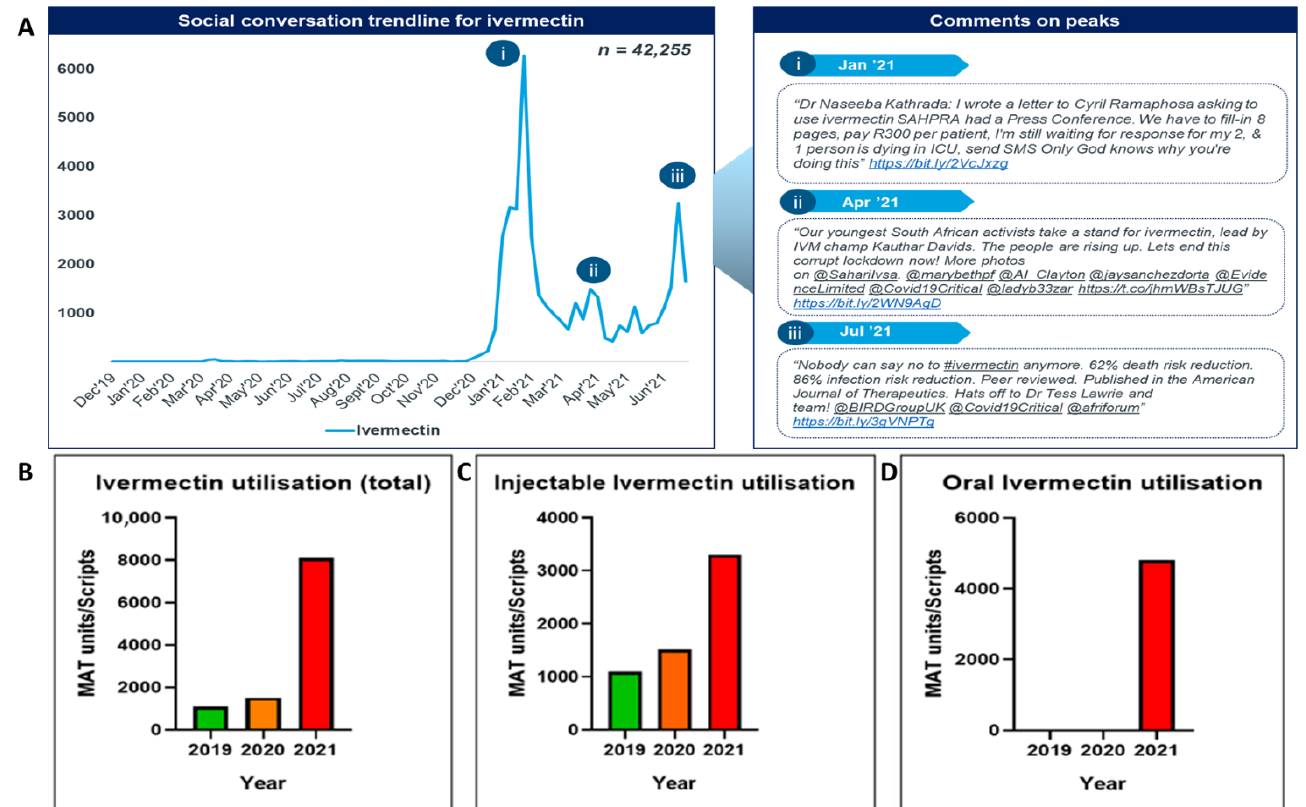
Figure 2. Social conversation trendline vs. moving annual total (MAT) units/scripts for ivermectin. ( A ) Social conversation trendline for Ivermectin and comments on peaks. ( B ) Ivermectin utilisation (total). ( C ) Injectable Ivermectin utilisation. ( D ) Oral Ivermectin utilisation.